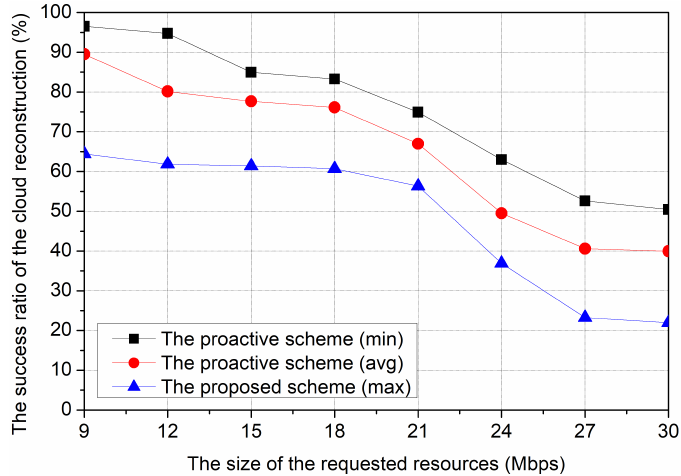
Figure 5. The success ratio of the cloud reconstruction for the size of the requested resources.